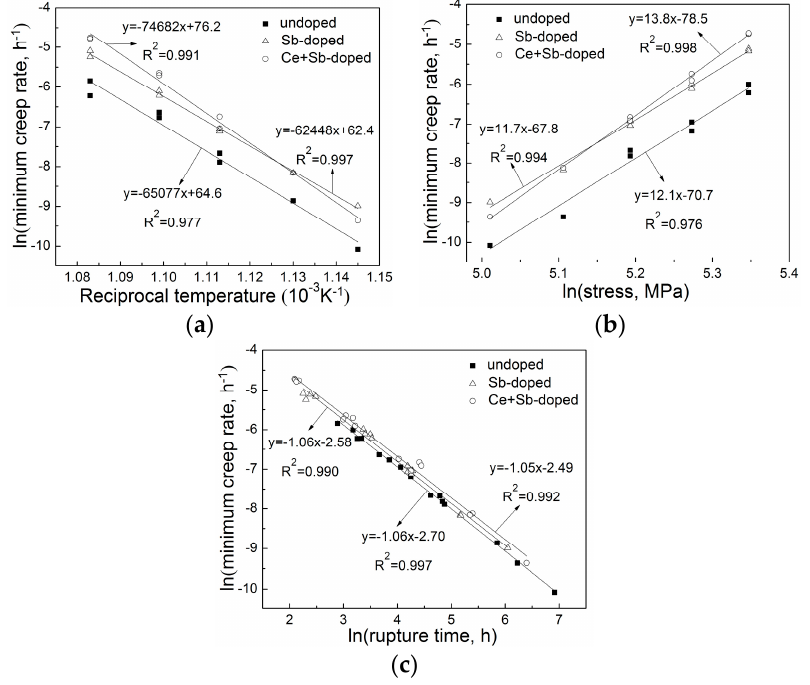
Figure 1. Variation of minimum creep rate with: ( a ) reciprocal temperature under a stress of 150 MPa; ( b ) stress at a temperature of 873 K; and ( c ) rupture time for the undoped, Sb ‐ doped, and Sb+Ce ‐ doped steels.